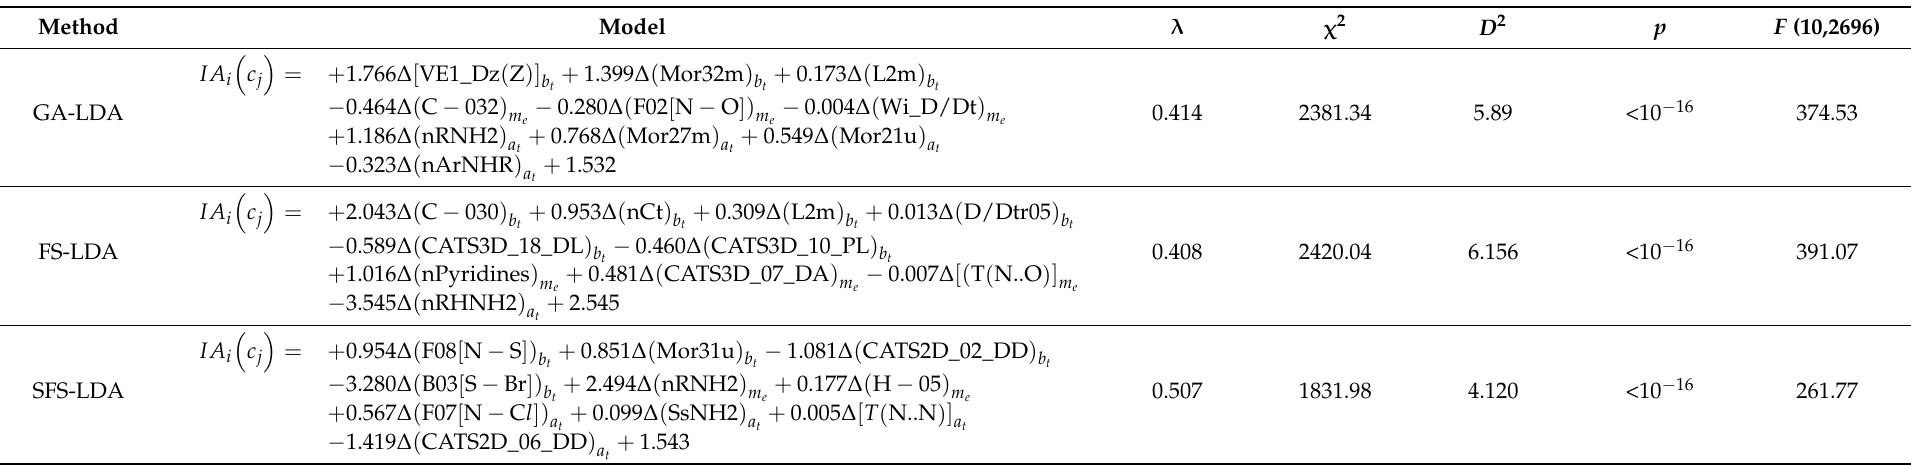
Table 1. Goodness-of-fit of the linear models produced by different feature selection